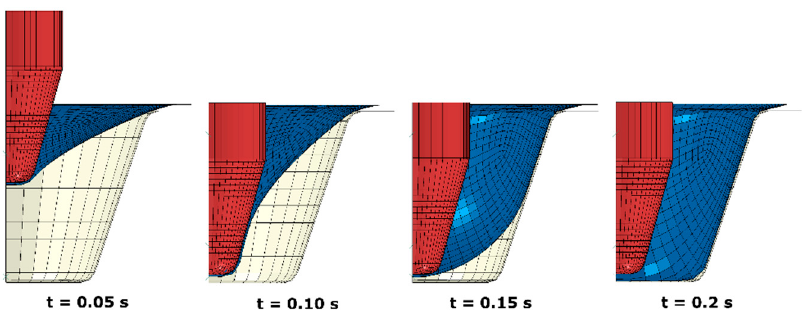
Figure 4. Shape evolution of poly (L-lactic acid) PLA sheet (blue) at forming process (T p = 77 °C).